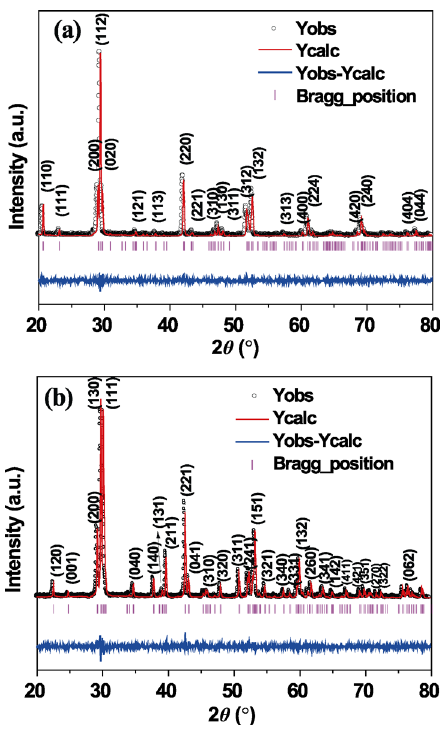
Fig. 3 Rietveld refinement profiles of XRD patterns of sintered powders of (a) SrCeO 3 and (b) Sr 2 CeO 4 .